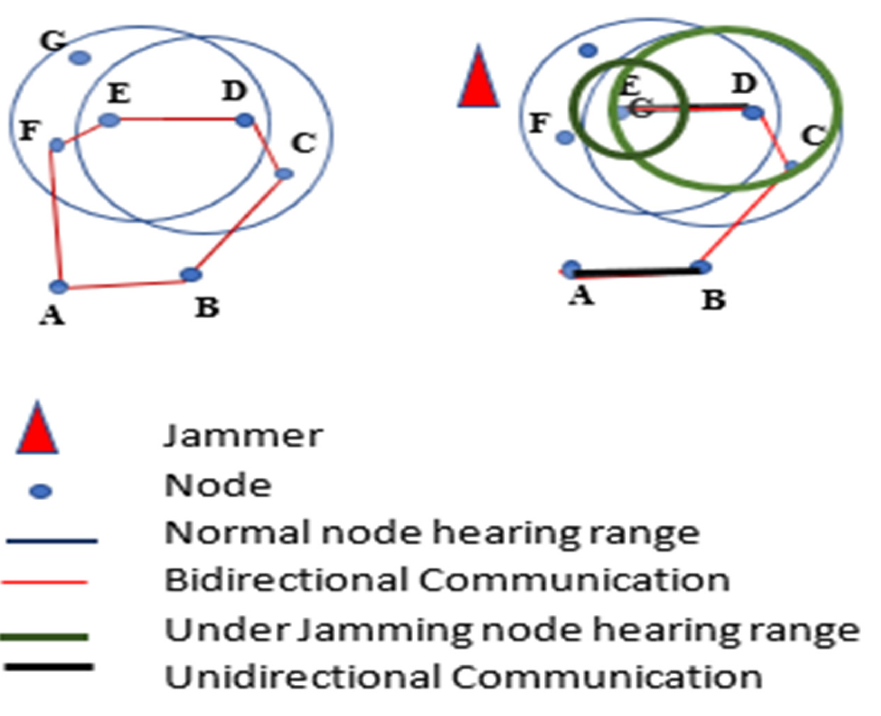
Figure 22. Jamming effects on WSNs.